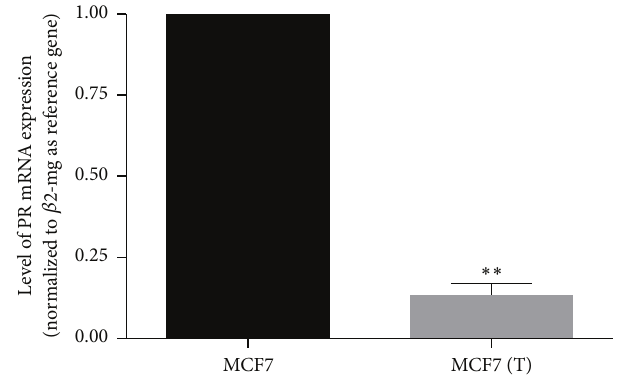
expressions of both ER and PR. In his study, Johnston et